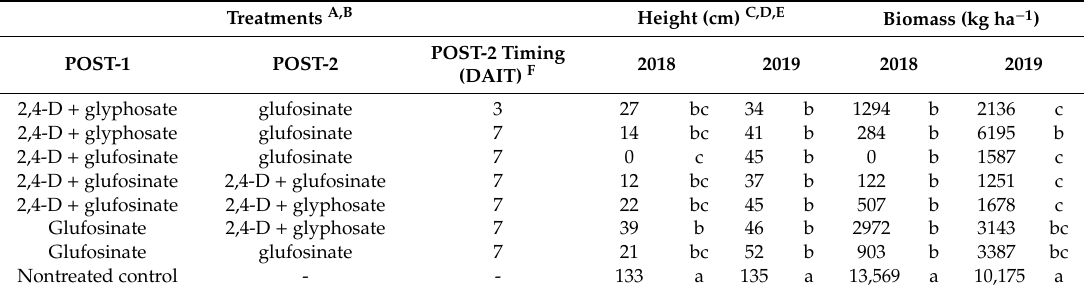
Table 3. Palmer amaranth height and biomass as a ff ected by sequential applications of 2,4-D and glufosinate in 2018 and 2019 field